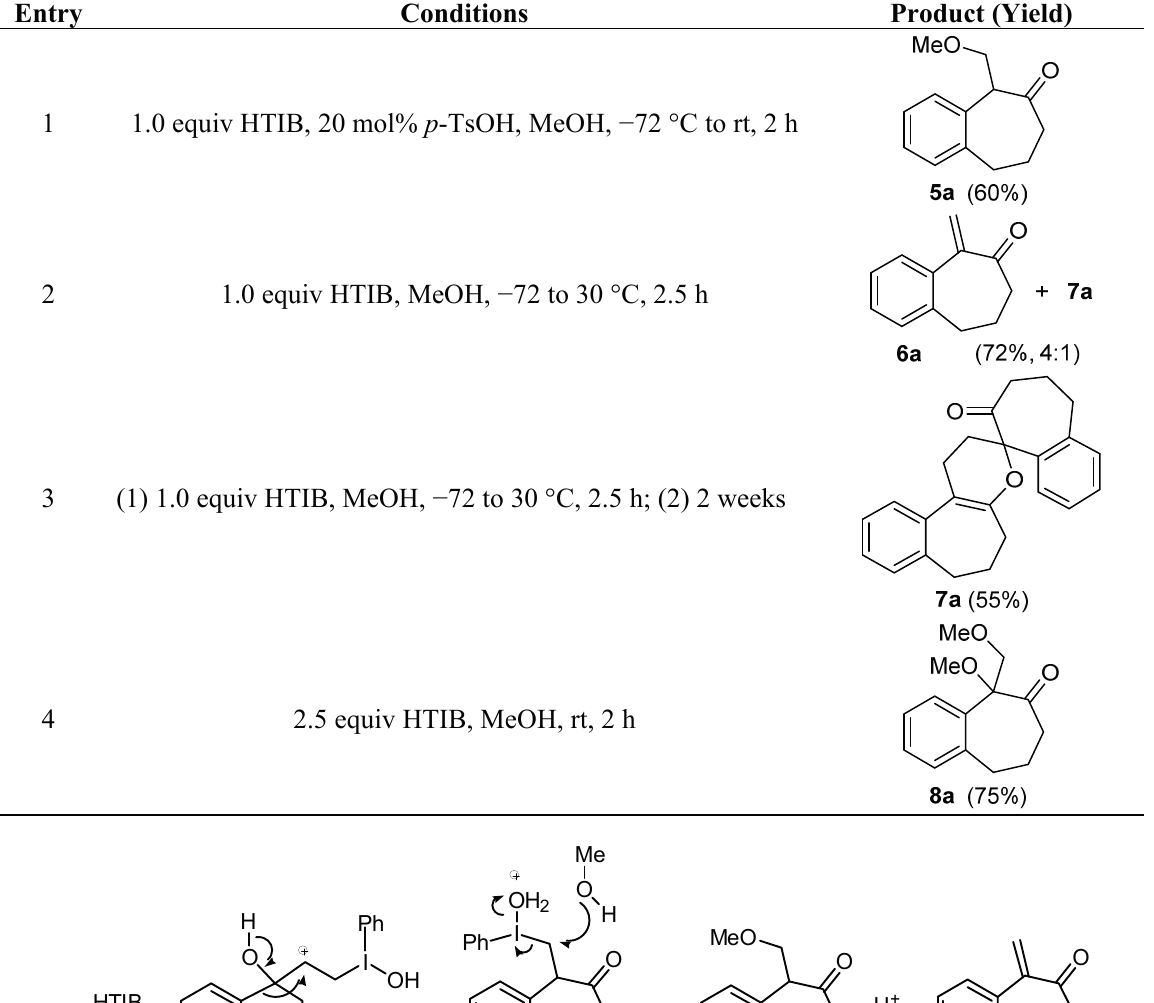
Table 1. HTIB-Mediated Ring Expansion of 3a . HTIB: [Hydroxy(tosyloxy)iodo]benzene; p -TsOH: p -Toluenesulfonic acid.